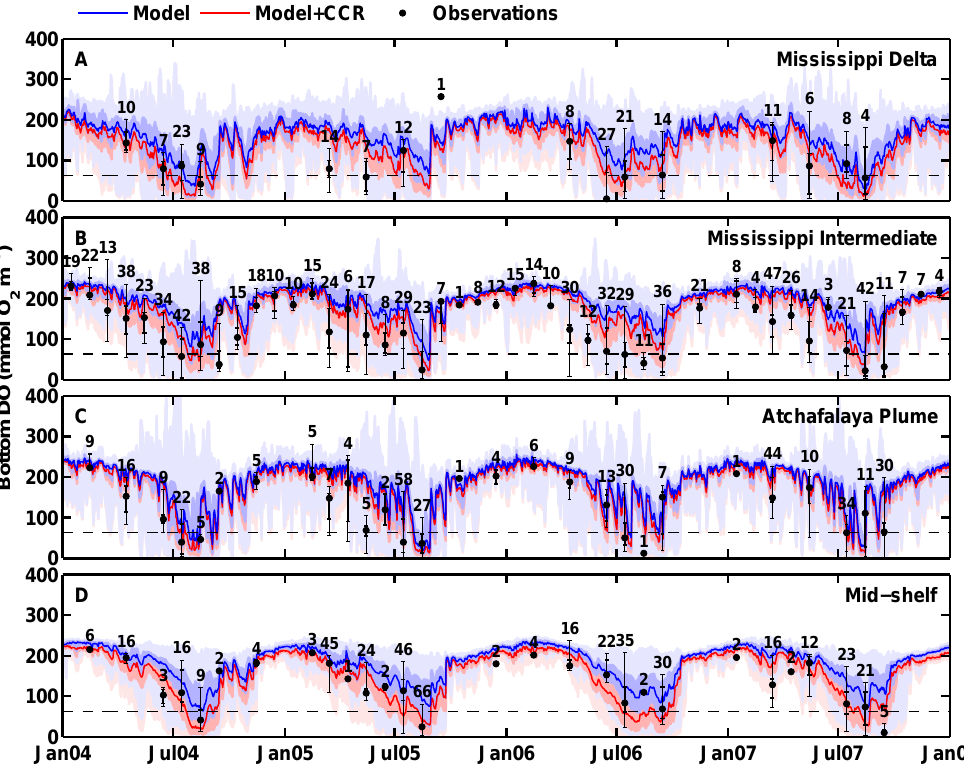
Figure 4. Time series of simulated and observed dissolved oxygen concentration (DO) in bottom water in the Mississippi Delta, Missis- sippi Intermediate, Atchafalaya Plume, and Mid-shelf regions. For the simulations, the medians are shown as solid lines (Model: blue line; Model + CCR: red line), the range between the 25th and 75th percentiles as dark-blue/red area, and the range between the minimum and maximum value as light-blue/red area. For the observations, the medians of monthly binned observations are shown as black dots, the range between the 25th and 75th percentiles as thick vertical lines, and the range between minimum and maximum values as thin vertical lines. The number of observations in each monthly bin is given above each maximum value. The dashed line indicates the hypoxia criterion of 62.5mmolO 2 m − 3 . Observations are from Rabalais et al. (2007), Lehrter et al. (2009, 2012), Nunnally et al. (2012), Murrell et al. (2014), and the MCH